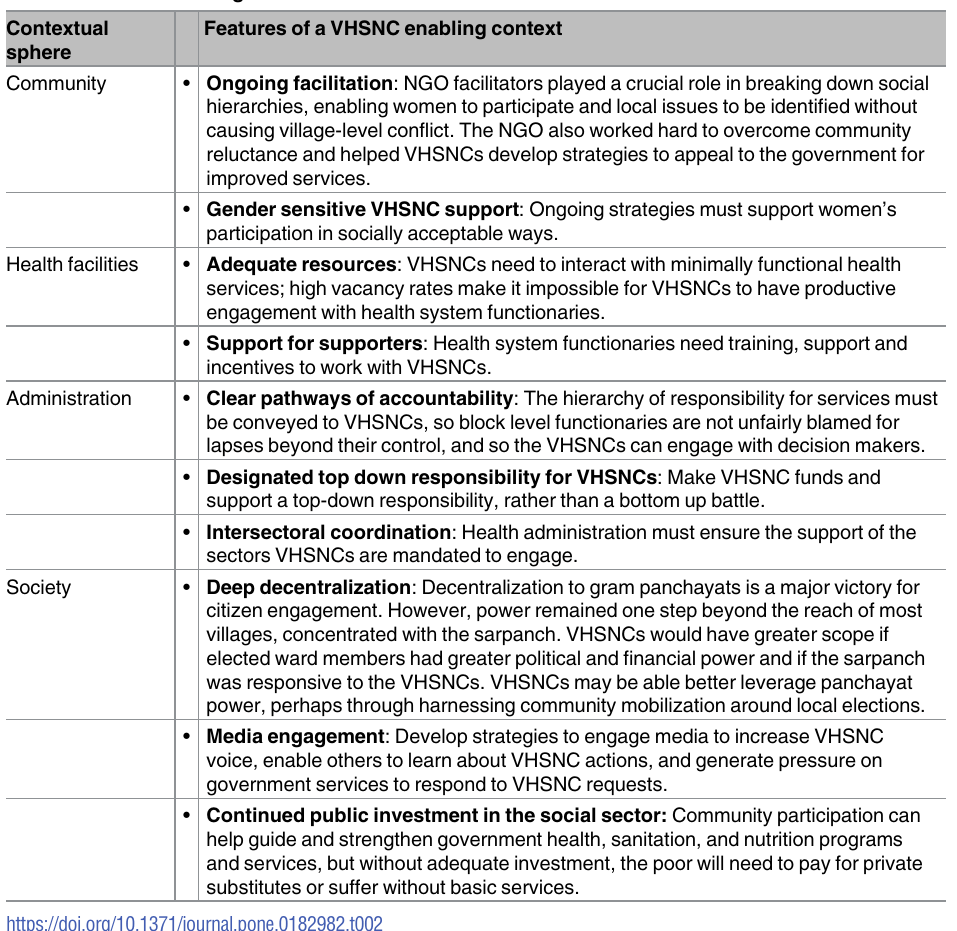
Table 2. VHSNC-enabling